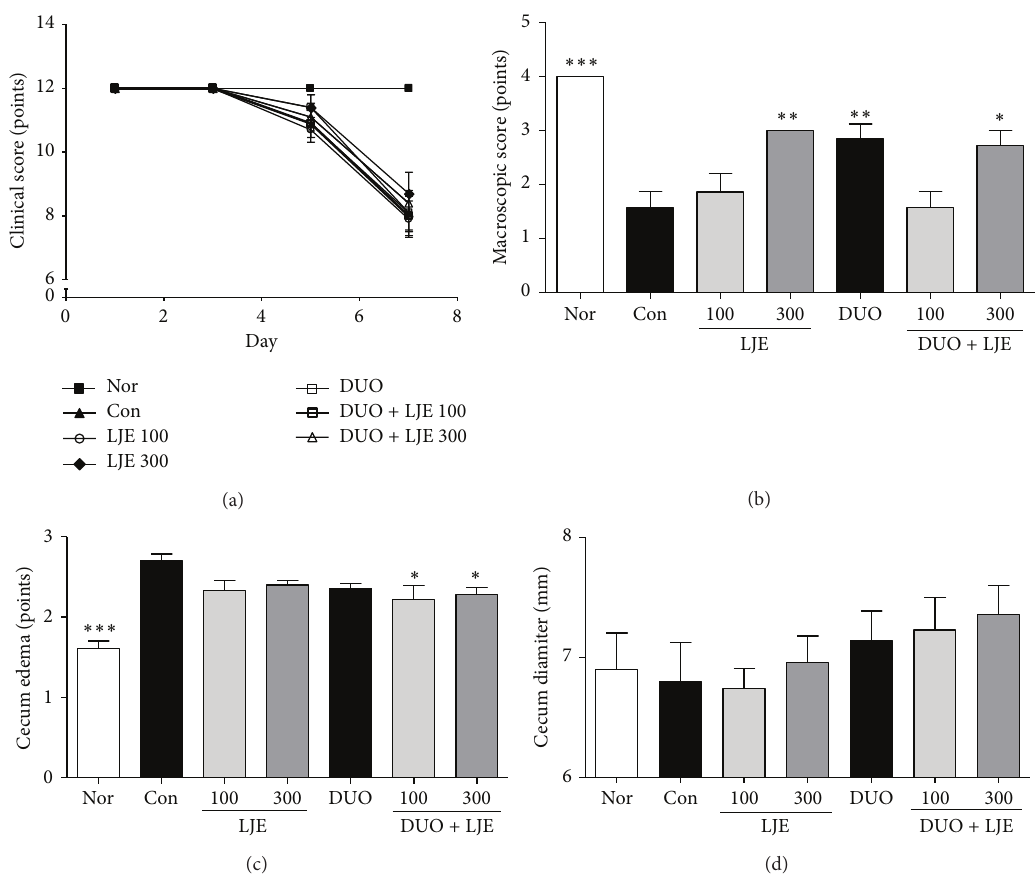
Figure 3: (a) Effects of LJE or DUO on clinical score in DSS-induced colitis. (b) Effects of LJE or DUO on gross macroscopic finding of colon in DSS-induced colitis. (c) Effects of LJE or DUO on cecum edema in DSS-induced colitis. (d) Effects of LJE or DUO on cecum diameter in DSS-induced colitis. Data are expressed as mean ± S.E.M ( 𝑛 = 7 ). Nor: normal mice without any treatment, Con: mice provided with only 5% DSS treatment, LJE: the water extract of Laminaria japonica , DUO: Duolac7S, LJE + DUO: cotreatment of LJE and DUO, 100: the dosage of LJE 100 mg/kg, and 300: the dosage of LJE 300 mg/kg; ∗ 𝑃 < 0.05 , ∗∗ 𝑃 < 0.01 , and ∗∗∗ 𝑃 < 0.001 versus control group analyzed by one-way ANOVA with Dunnett’s post hoc